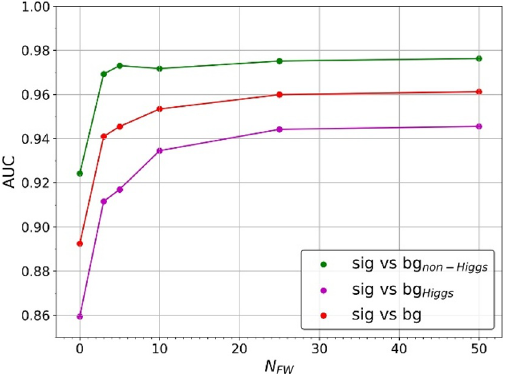
Figure 22 . AUC for jet-level classi(cid:12)ers with the (cid:12)rst N FW FW moments, to distinguish the Z (cid:23) h W from its background